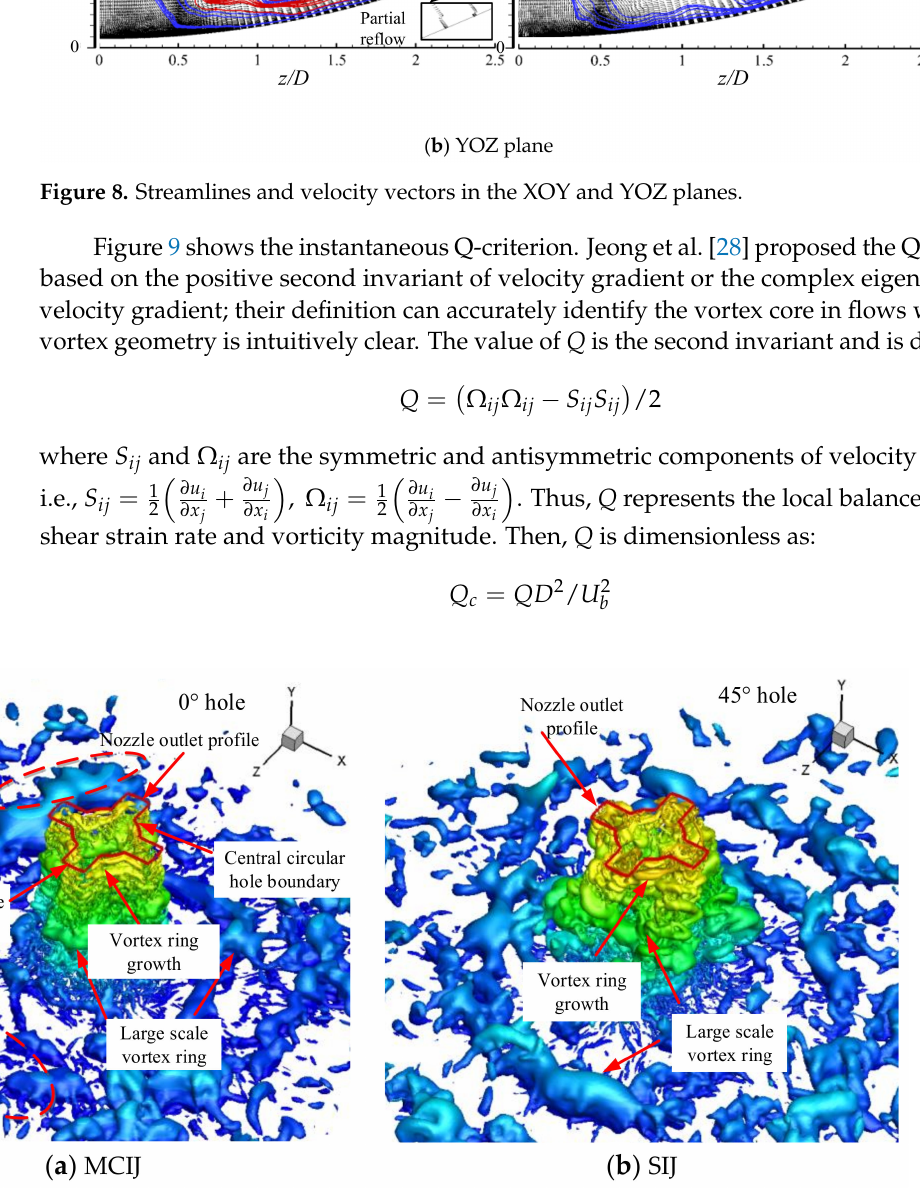
Figure 9. Instantaneous iso-Q-criterion surface for the MCIJ and